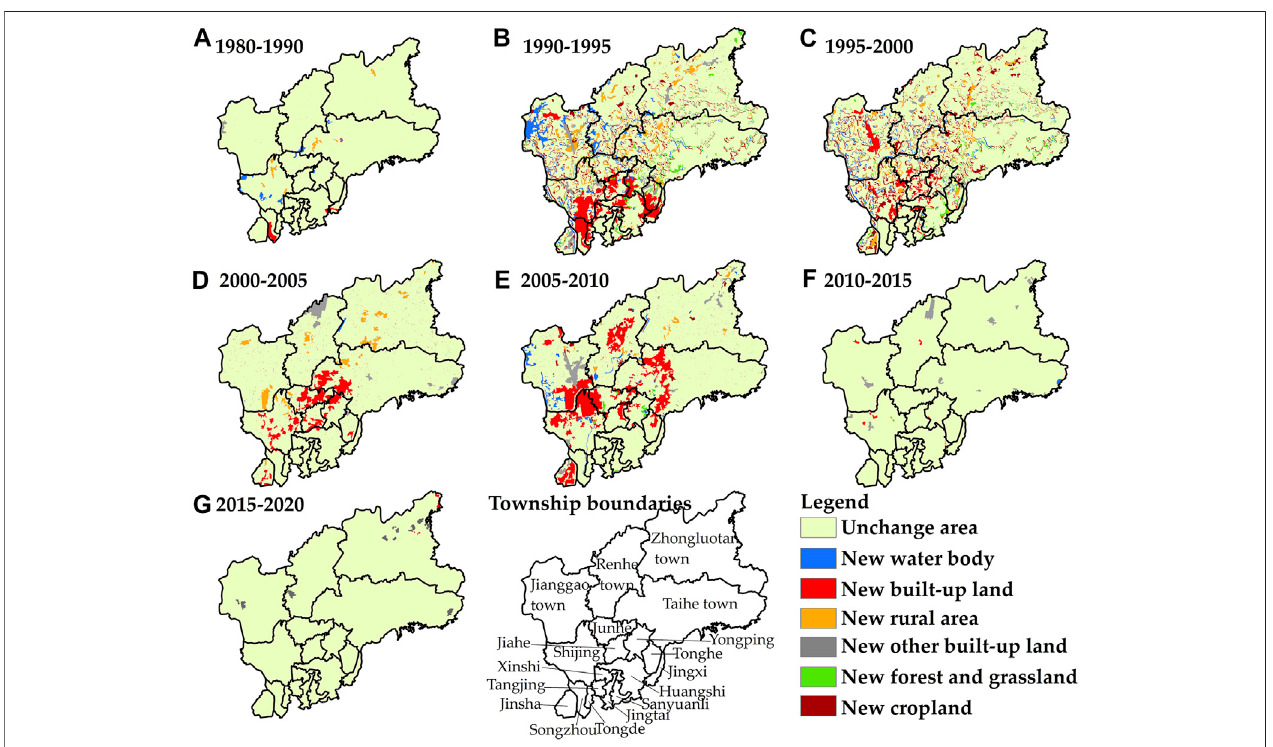
FIGURE 4 | Spatial distribution of new land in each township at different times (A – G) .